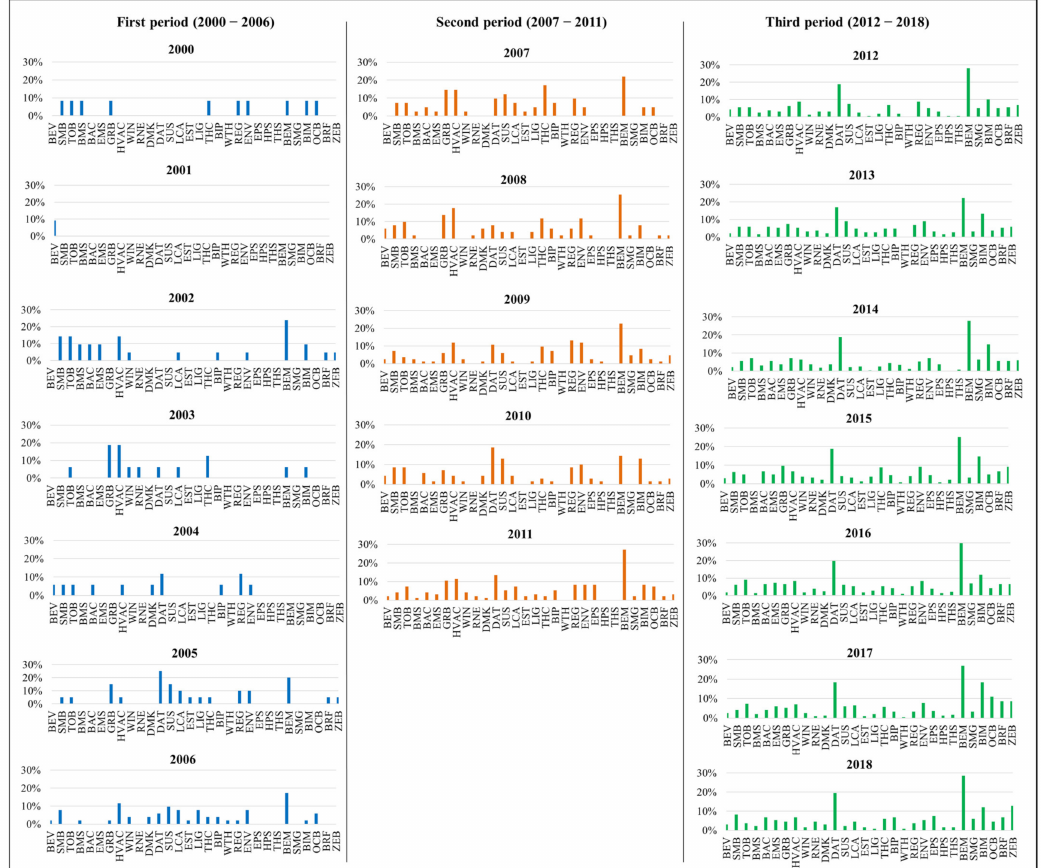
Figure 7. Column profile from each period (source: